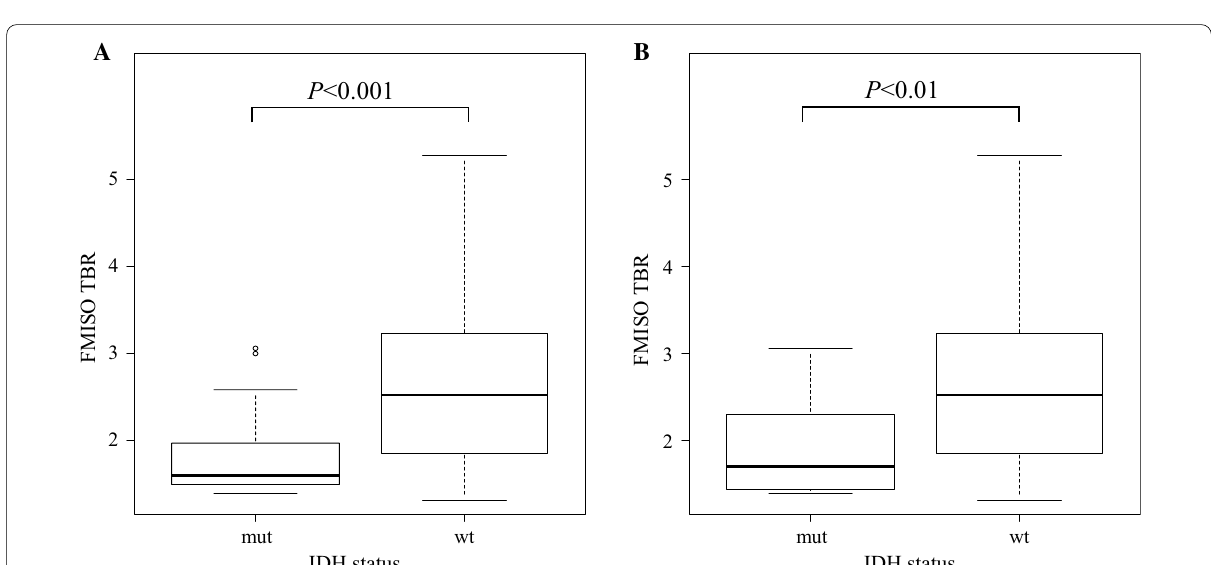
Fig. 1 a Box plots showing the FMISO TBR in relation to IDH1 mutation status in all gliomas ( n 87). The FMISO uptake in IDH1 -wildtype (wt) = tumors was significantly higher than that in IDH1 -mutant (mut) tumors ( P < 0.001). b Box plots showing the FMISO TBR in relation to IDH1 mutation status in malignant astrocytomas ( n 76; 18 AAs and 58 GBMs). The FMISO uptake in IDH1 -wildtype (wt) tumors was significantly higher than that in = IDH1 -mutant (mut) tumors ( P < 0.01)